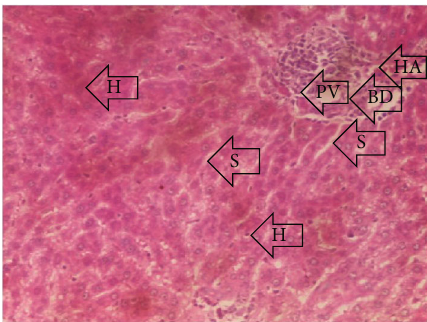
Figure 5: Photomicrographs of the group IV rats with normal liver of congested central vein (CV), intact hepatocytes, and sinusoids containing Kup ff er cells.